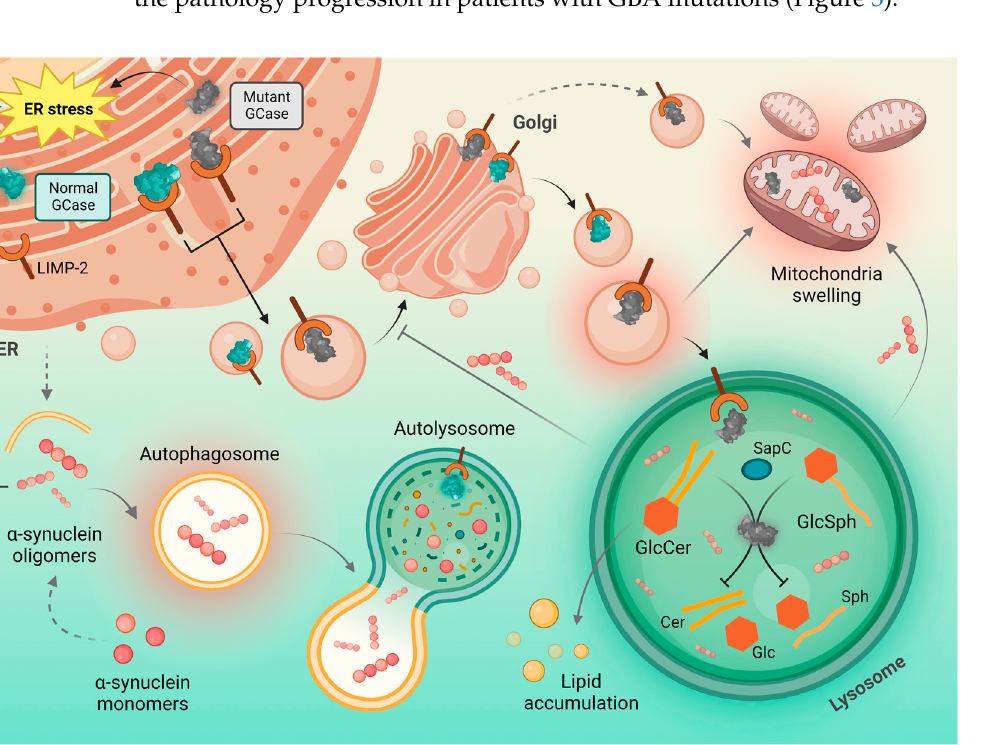
Figure 3. Molecular mechanisms underlying GCase mutations and the associated cellular events. Under normal conditions, the functional GCase is synthesized in the ER, bound to lysosomal integral membrane protein type-2 (LIMP-2) and transferred to the Golgi apparatus for glycosylation. Then, it is targeted to the lysosomes, where it catalyzes degradation of glucosylceramide (GlcCer) and glucosylsphingosine (GlcSph) to glucose and ceramide or glucose and sphingosine, respectively; Saposin C (SapC) acts as a cofactor in this process. However, in the case of mutant GCase, the activity of enzyme is markedly decreased, which leads to accumulation of GlcCer and GlcSph, and in consequence—lipid imbalance. Impaired function of GCase also affects the degradation of other lysosomal substrates, such as α -synuclein oligomers. Accumulation of mutant GCase and α -